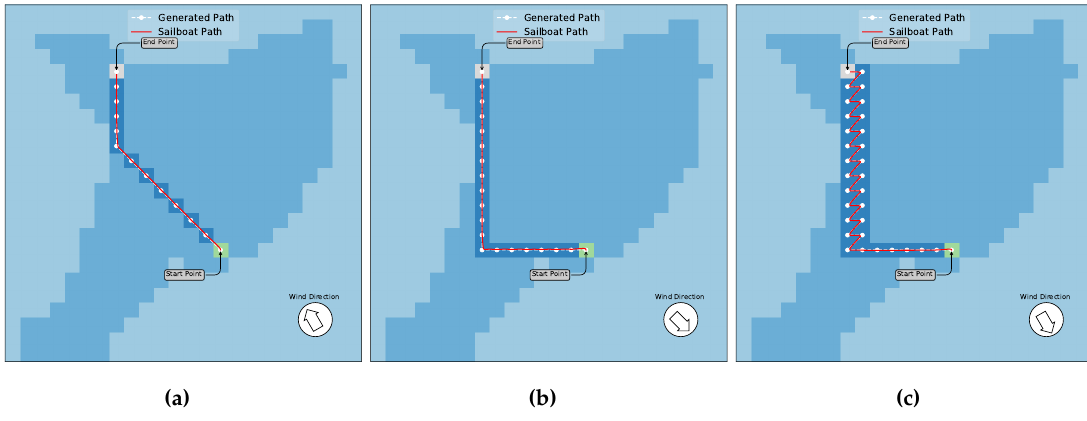
Figure 13. Three scenarios with the same start and end points and change in wind direction. The wind direction in Figure ( a – c ) are 315, 120 and 145 degrees,